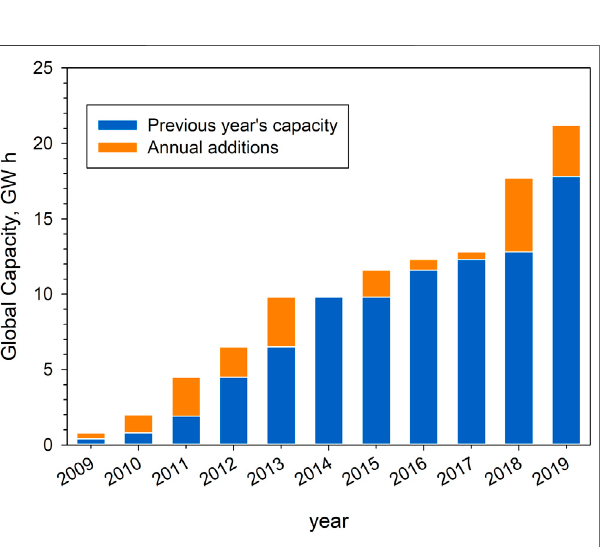
Frontiers in Energy Research |